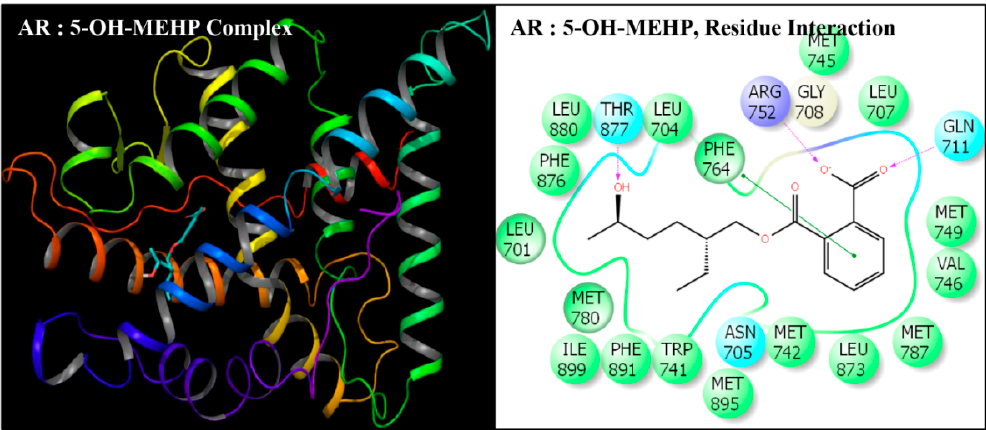
Figure 4. Ribbon diagram representing the docking pose of human androgen receptor (AR) with mono-(2-ethyl-5-hydroxyhexyl)phthalate (5-OH-MEHP) (left panel). The interactions of ligand (5-OH-MEHP) with amino-acid residues in the binding pocket of AR (right panel).